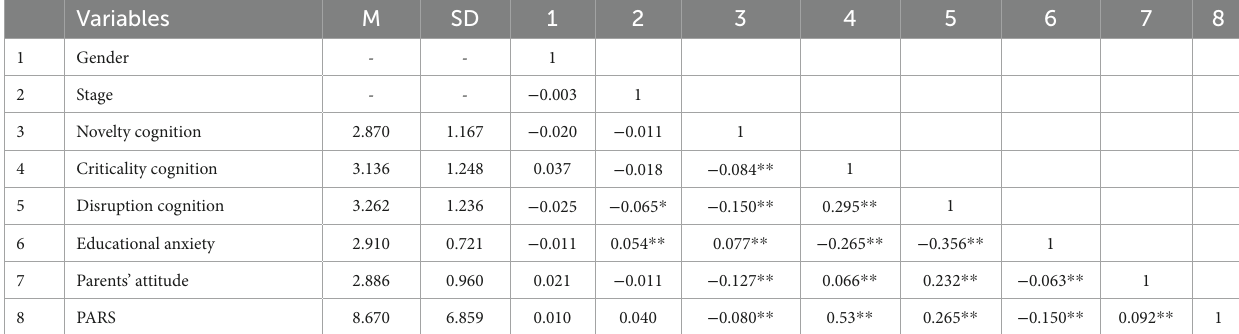
TABLE 2 Descriptive statistics and correlation analysis results of cognition variables.